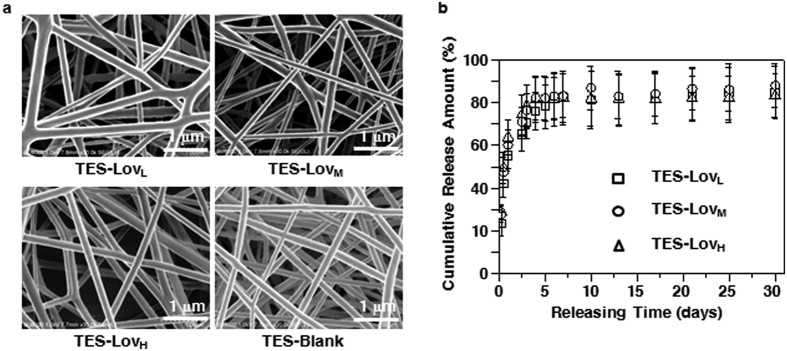
Morphology and in vitro drug release profile of TESs.(a) Representative SEM images of TESs with theoretical Lov loading amounts of 1.0% (TES-LovL), 5.0% (TES-LovM) and 10% (TES-LovH) and blank TES without drug loading (TES-Blank). (b) In vitro release profiles for TES-LovL, TES-LovM and TES-LovH. All values represent the means and SD; n = 6.